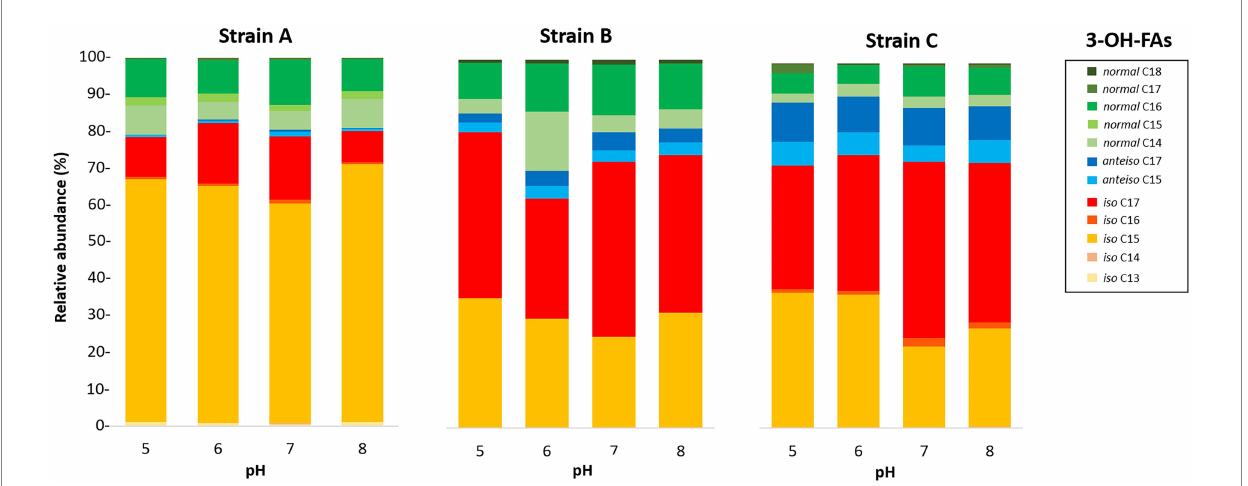
FIGURE 2 Variation of the relative abundances of 3-OH FAs with pH for the three Bacteroidetes strains isolated from different altitudinal soils of the French Alps. Strain A: Flavobacterium pectinovorum (98.78% similarity). Strain B: Pedobacter lusitanus NL19 (98.54% similarity). Strain C: Pedobacter panaciterrae (99.27%